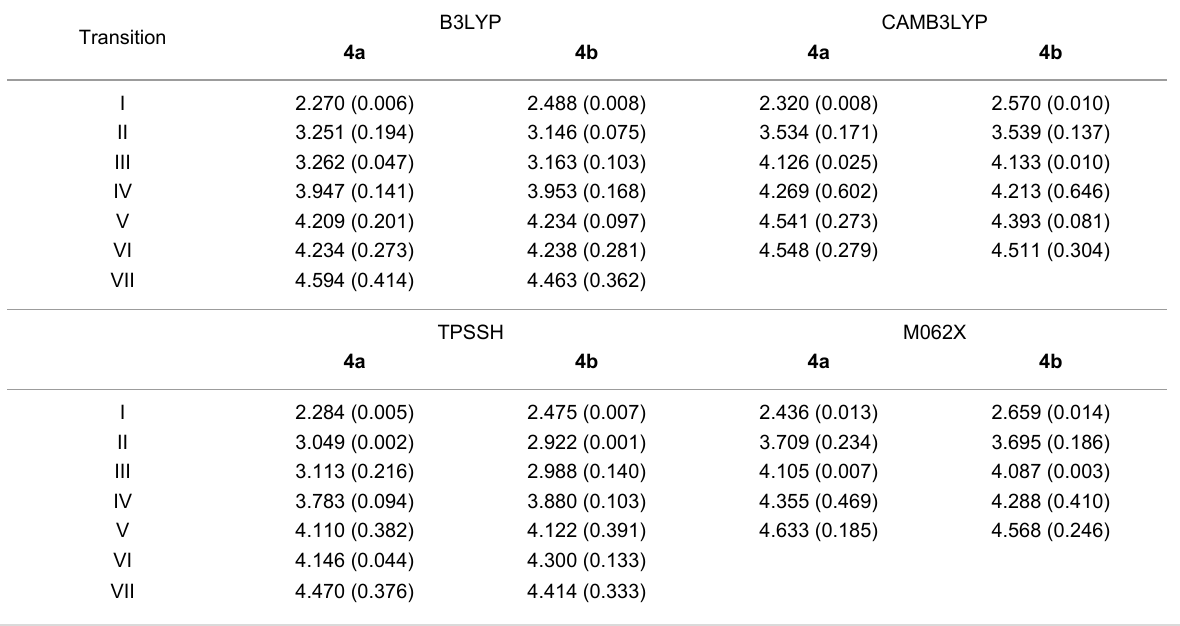
Table 4: 6-311+G(d,p) vertical excitations in eV (oscillator strength) for 4a and 4b in increasing energy order.